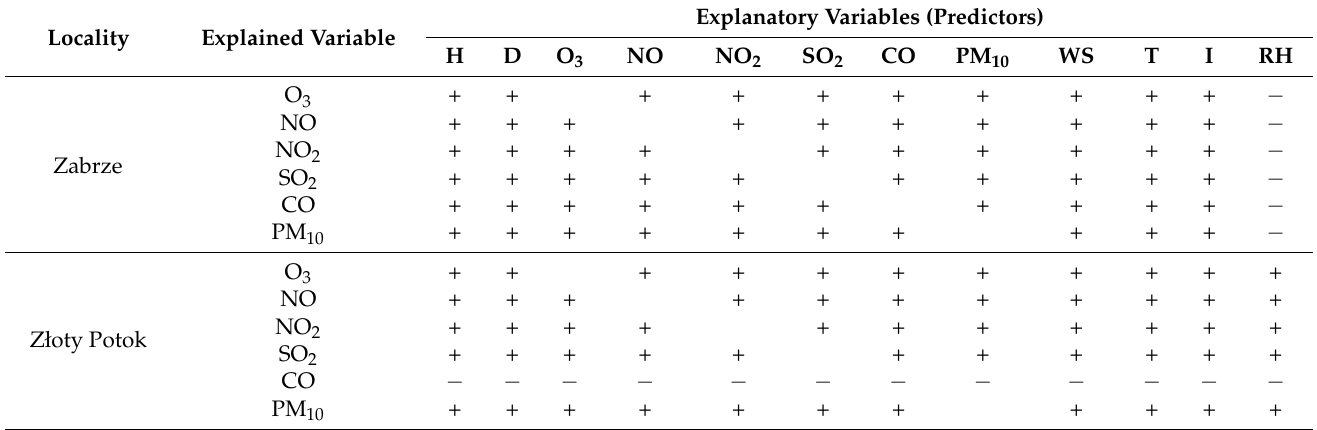
Table 2. Classification of predictors for individual models at both air monitoring stations. A + symbol means the variable was treated as an input in the model. A − symbol means no